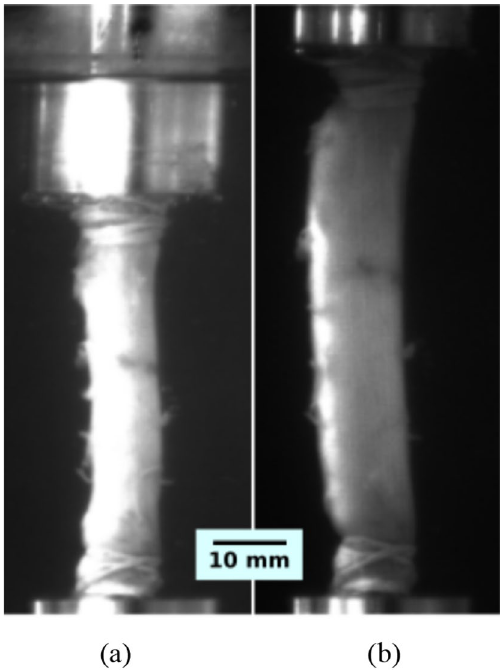
Figure 1. Experimental assembly of the pressurization test. ( a ) Thoracic aorta without stretching and free of loads, immersed in Krebs; ( b ) Pressurization of a previously stretched thoracic aortic